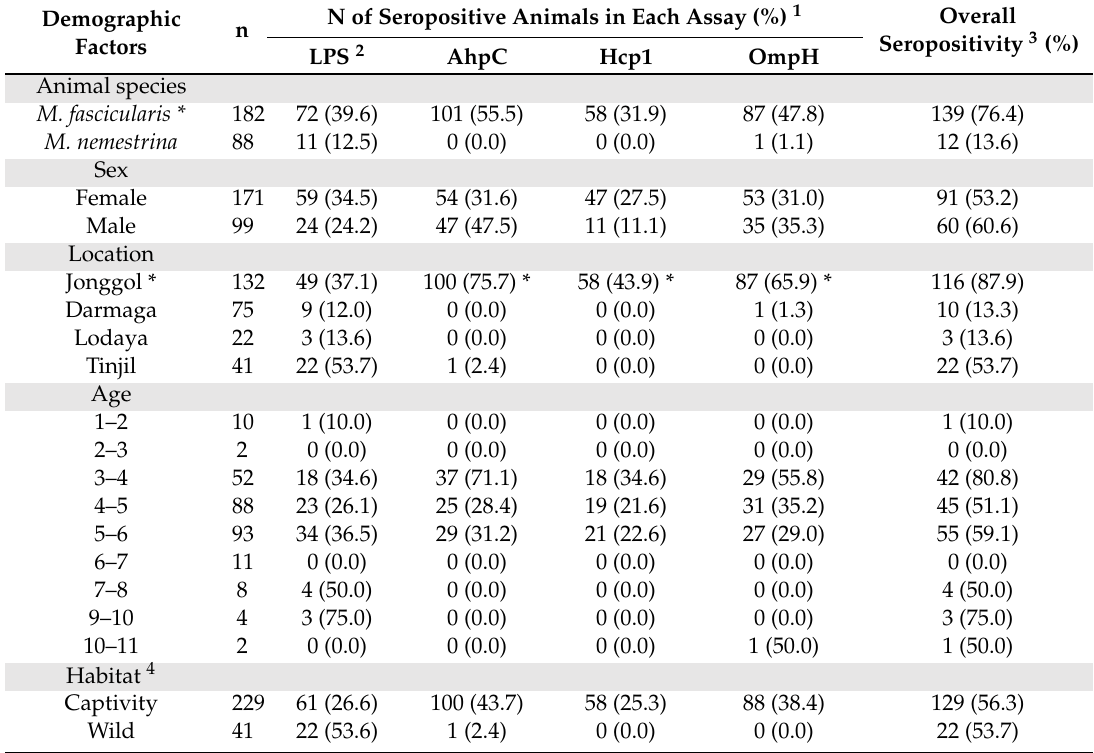
Table 1. Seroprevalence in macaques by demographic